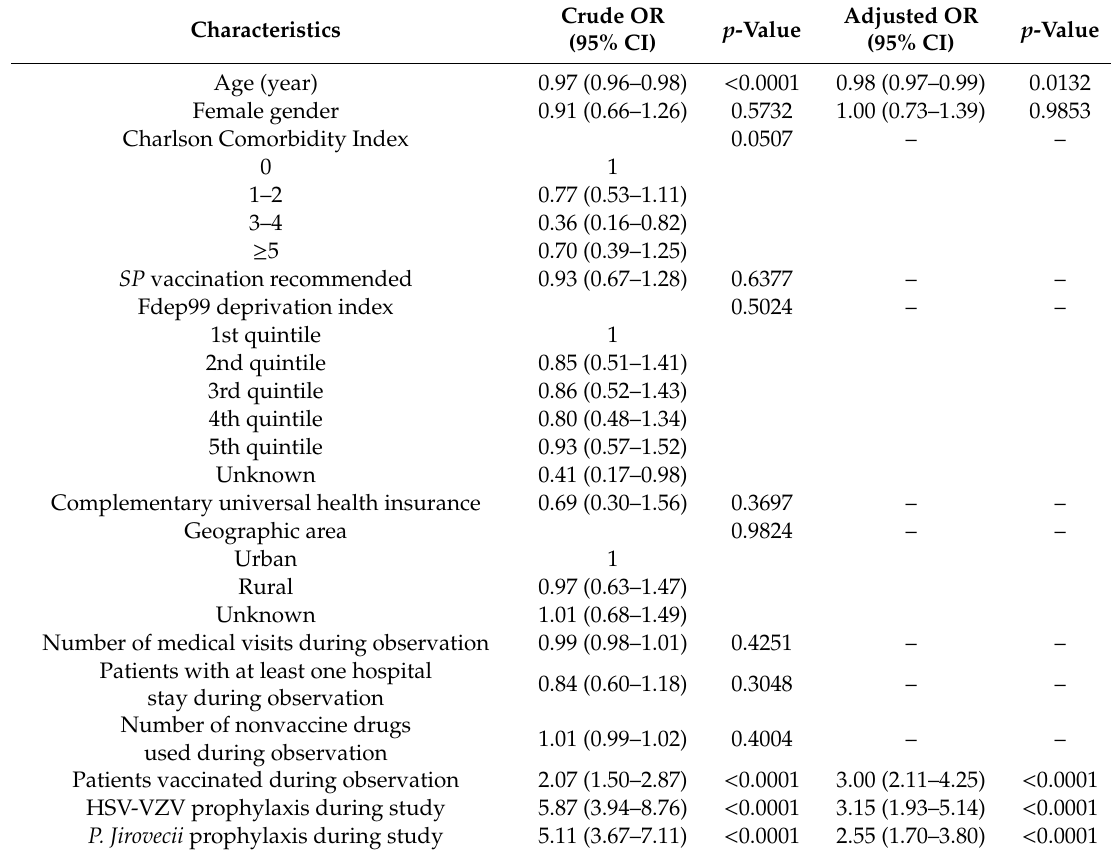
Table 4. Logistic regression model for factors associated with vaccination against influenza, SP, and Hib during the study period—primary outcome.